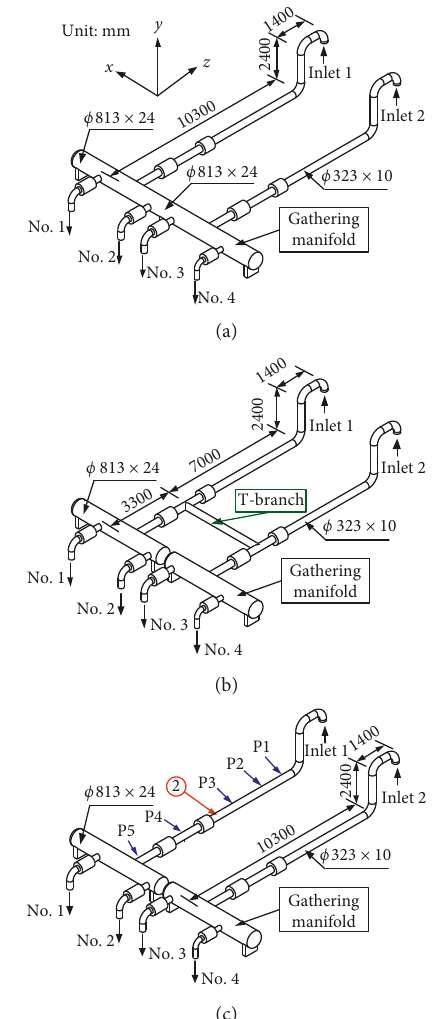
Figure 6: Three models of the inlet pipeline modifications for vibration reduction. (a) Model A: one manifold; (b) model B: two manifolds connected by T branch; (c) model C: two